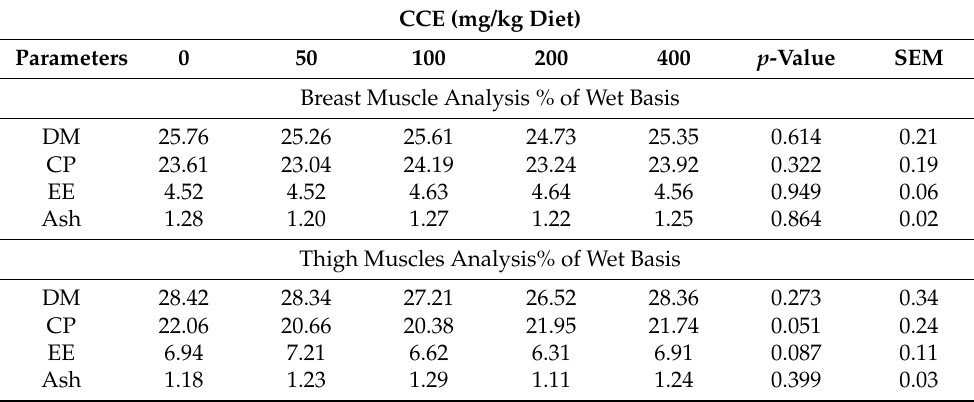
Table 5. Effect of different levels of cornelian cherry extract (CCE) on breast and thigh muscle chemical analysis of broiler chickens % on wet basis. CCE (mg/kg Diet) Parameters 0 50 100 200 400 p -Value Breast Muscle Analysis % of Wet Basis